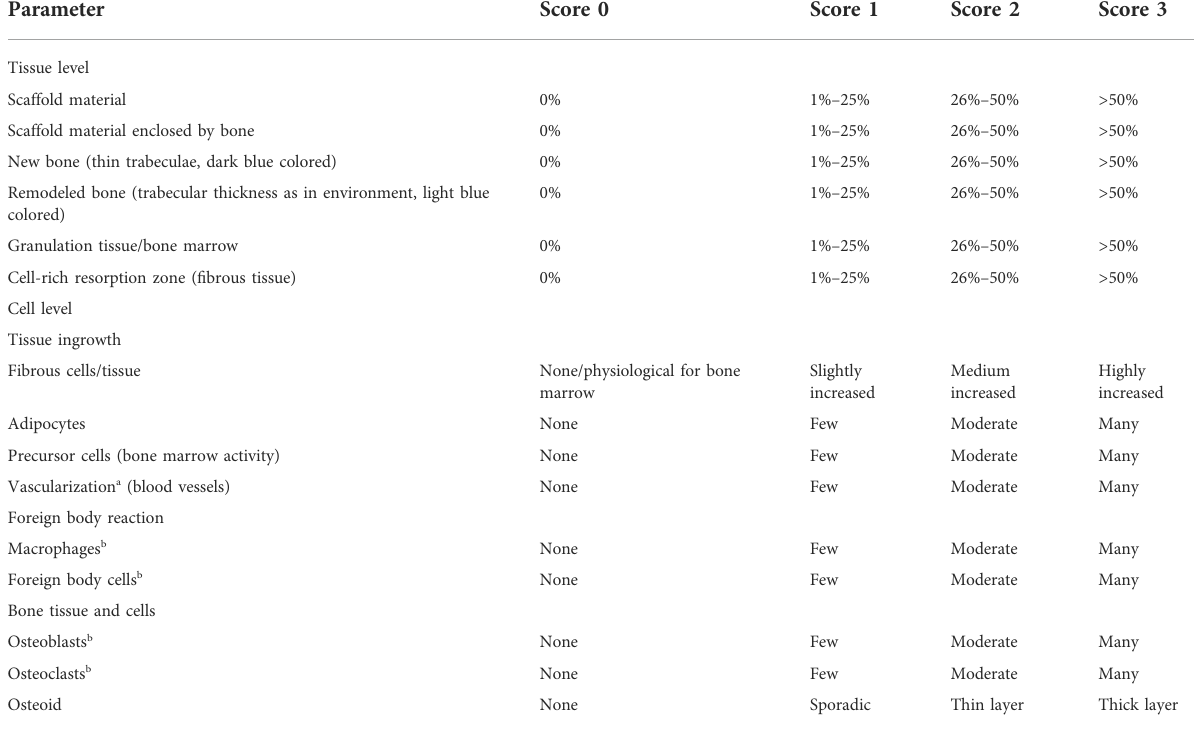
TABLE 4 Scoring system for the semi-quantitative histological evaluation of tissue and cells.